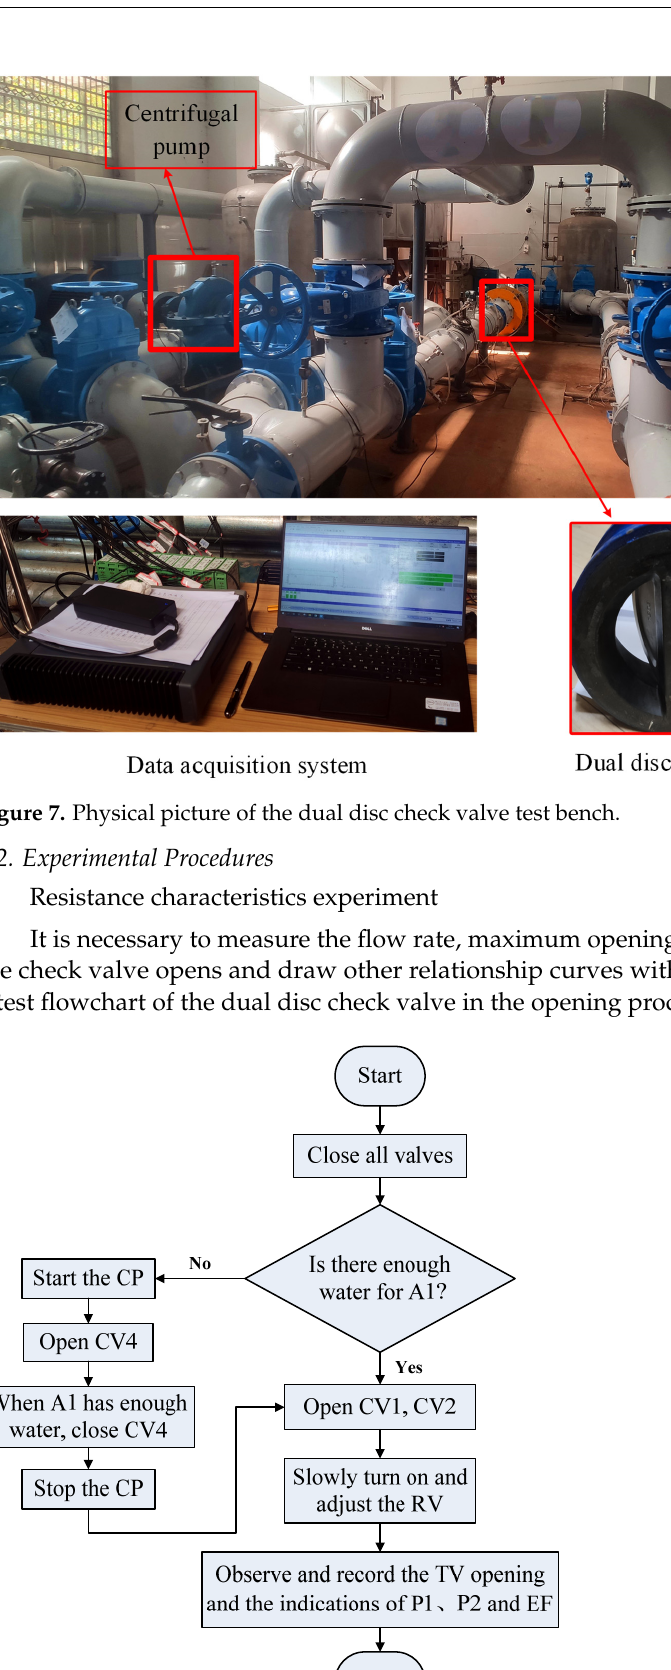
Figure 6. Dual disc check valve test system.